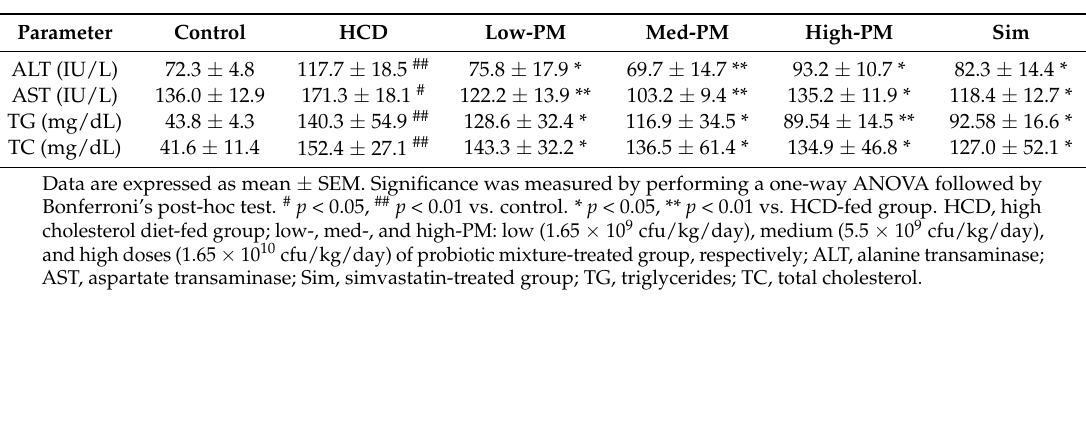
Table 2. Levels of hepatic ALT, AST, and lipids in hypercholesterolemic rats.